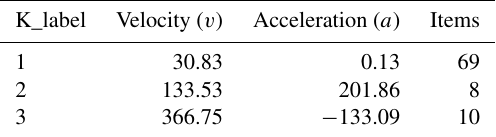
Table 2. Cluster centroids and number of items in each